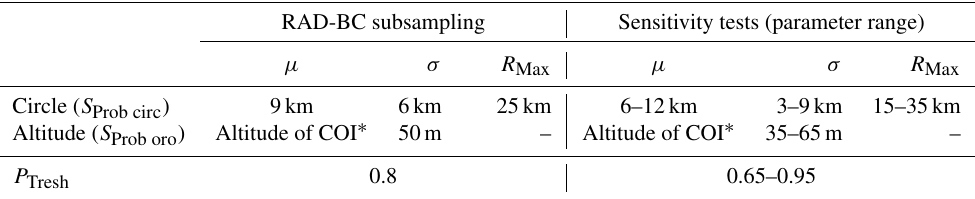
Table 1. Parameters used for defining the COI-specific sampling probabilities as well as the respective parameter range used to estimate the uncertainty related to the sampling